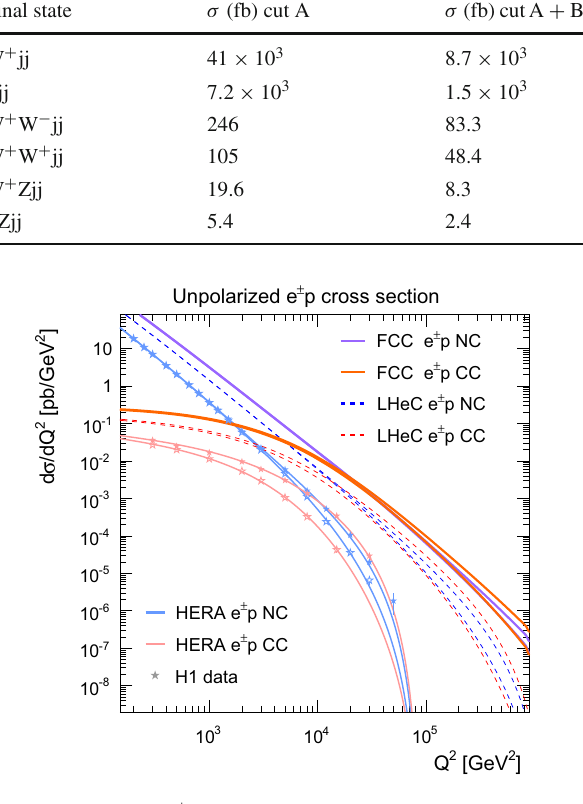
Fig. 3.5 Single differential cross sections for unpolarised e + p and e − p NC and CC DIS for FCC-eh in comparison to HERA measurements and LHeC expectations. The lepton beam polarisations of ± 80% will considerably change the expected NC cross section in regions where γ Z and pure Z exchange becomes important, whereas the CC cross section scales linearly with the lepton beam